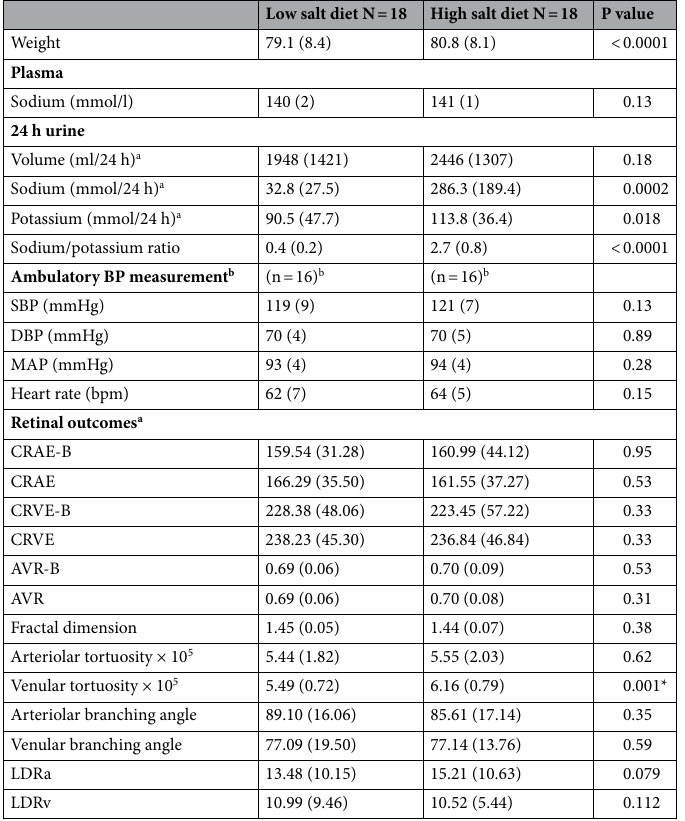
Table 2. Outcome measurements after low and high salt diet. All values are expressed as mean (SD), unless marked otherwise. BP blood pressure, SBP systolic blood pressure, DBP diastolic blood pressure, MAP mean arterial pressure, CRAE-B central retinal equivalent in zone B, CRAE central retinal equivalent in zone C, CRVE(-B) central retinal equivalent in zone B or C, AVR(-B) arteriovenous ratio in zone B or C, LDRa length diameter ratio arteriole. a Values are expressed as median (interquartile range). b Two participants had no ambulatory blood pressure measurements due to device malfunction.